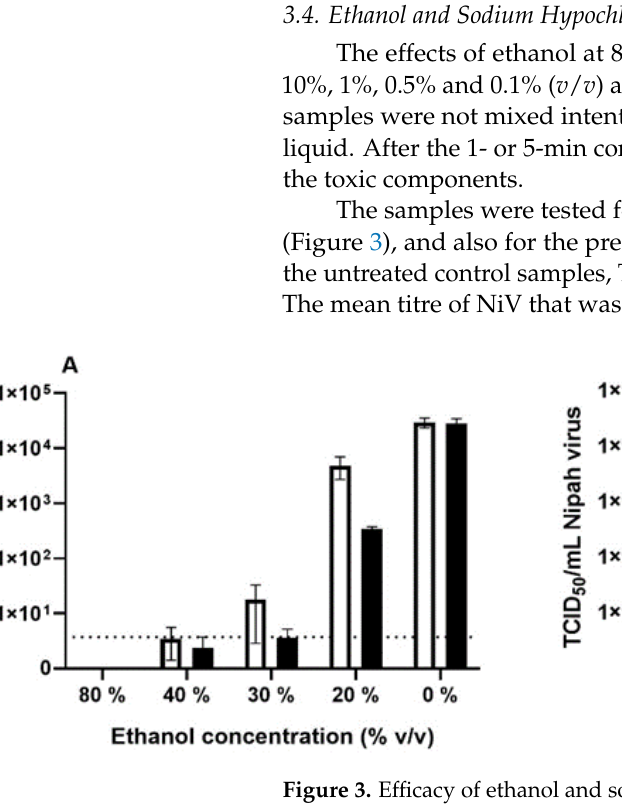
Figure 3. Efficacy of ethanol and sodium hypochlorite against NiV. Ethanol ( A ) or sodium hypochlorite ( B ) at a range of concentration percentages were tested for their effect on the titre of NiV with a 1 min (white bars) or 5 min (black bars) contact time. The titre values are means from multiple replicates ± SEM. Dotted line indicates the limit of detection of the TCID 50 assay.